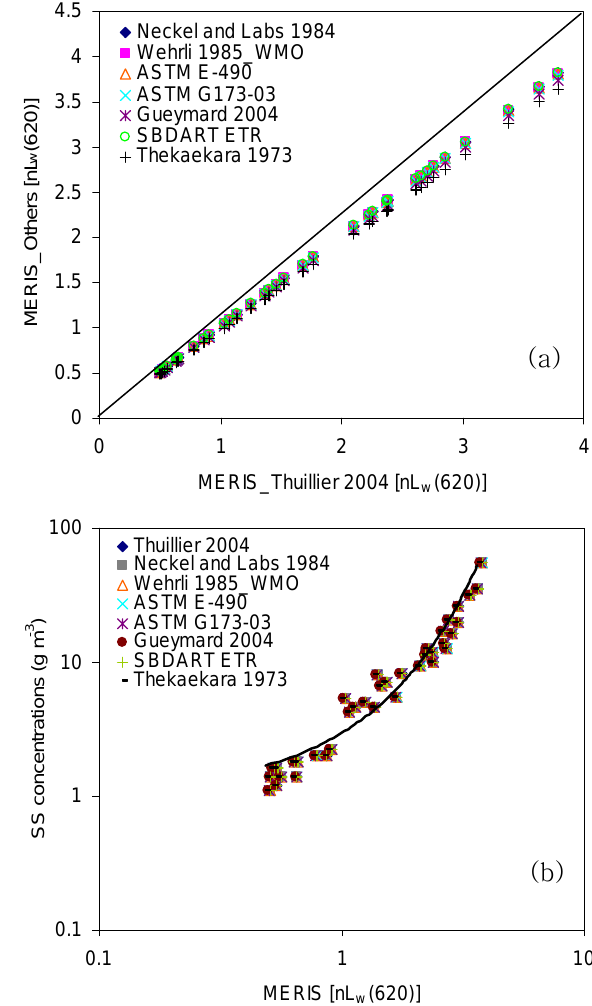
Fig. 10. (a) Scatter plot of the MERIS Others [nLw(620)] versus MERIS Thuillier 2004 [nLw(620)]. Others are the Neckel and Labs Fig. 10a. Scatter plot of the MERIS_Others [nLw(620)] versus MERIS_Thuillier 2004 [nLw(620)]. 1984, Wehrli 1985 WMO, ASTM E-490, ASTM G173-03, Guey- Others are the Neckel and Labs 1984, Wehrli 1985_WMO, ASTM E-490, ASTM G173-03, Gueymard mard 2004, SBDART ETR and Thekaekara 1973. (b) Log-log plot 2004, SBDART ETR and Thekaekara 1973. (b) Log-log plot of the MERIS [nLw(620)] as a function of of the MERIS [nLw(620)] as a function of the in-situ SS concentra- tions. The total number of observations, the in-situ SS concentrations. The total number of observations, N = 37.